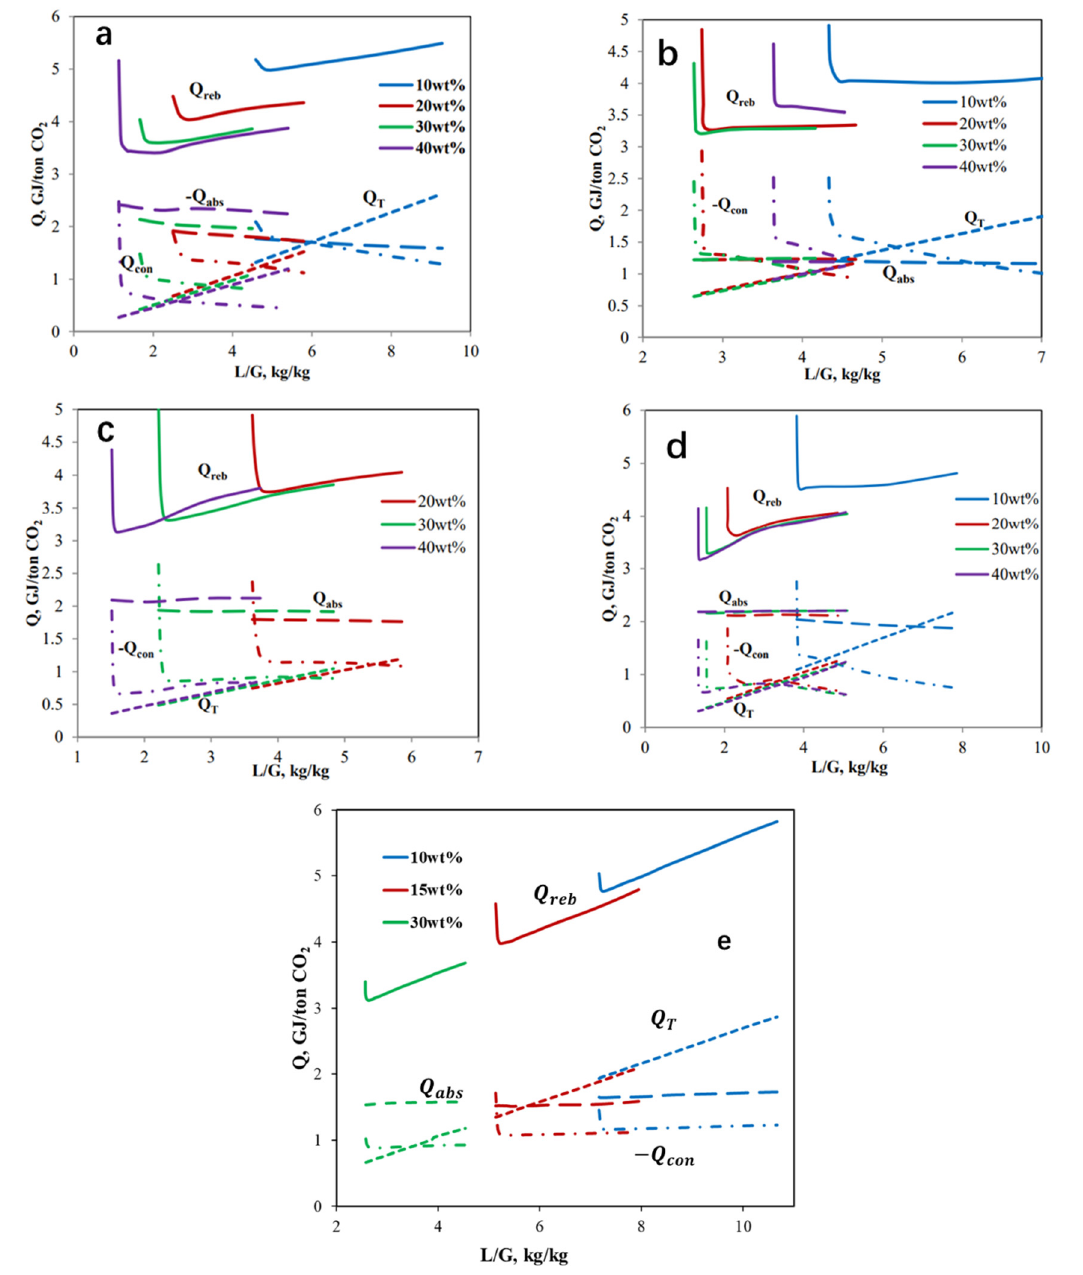
Figure 3. When the CO 2 partial pressure of flue gas is 10 kPa, and the pressure of the desorption tower is 2.2 bar, the influence of the concentration of aqueous amine solutions on energy consumption for: ( a ) MEA, ( b ) DMEA, ( c ) 1-MPZ, ( d ) AMP and ( e ) HEPZ, is shown.